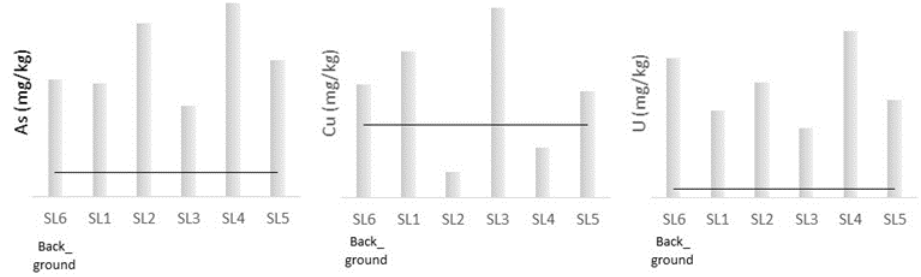
Figure 4. Projection of the soils from the Picoto mine area. Black solid line: parametric values for agricultural and residential uses [38].